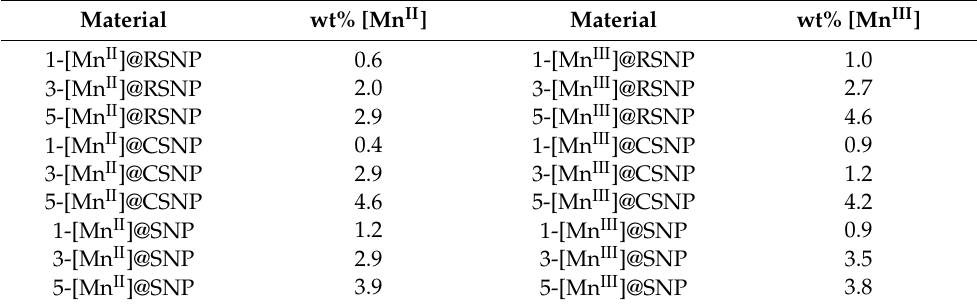
Table 1. Estimated manganese complex load (wt%) for the different nanoparticles from chemical analyses, TGA and magnetic